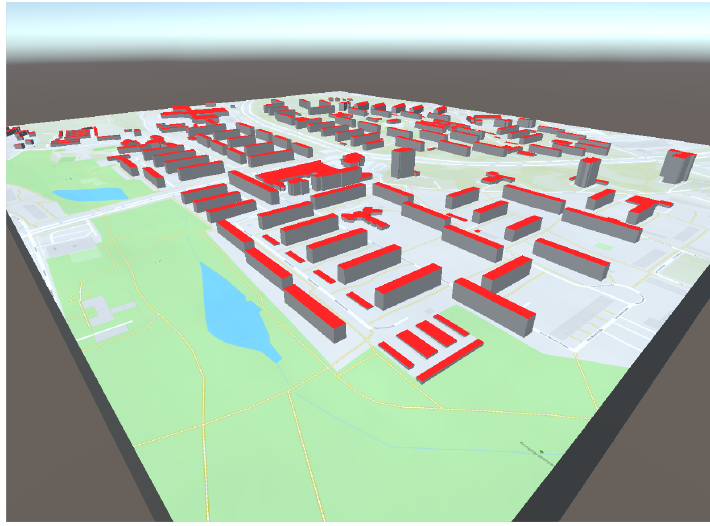
Figure 5. The segment of CityGML data used for testing this